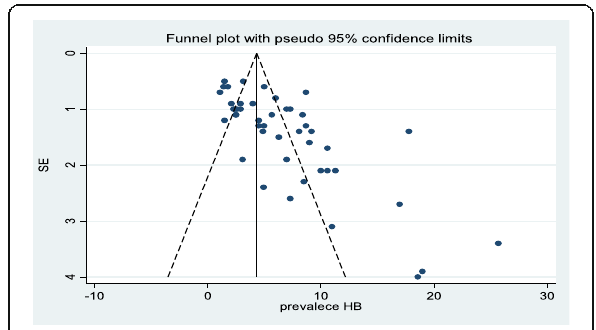
Fig. 4 Funnel plot showing publication bias of studies included for the prevalence of hepatitis B among health care workers in